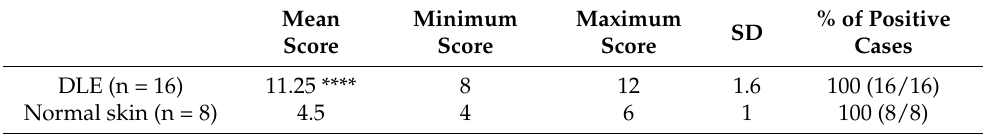
Table 2. Mean ( ± SD) score of TRL4 expression in DLE and normal skin; **** p <